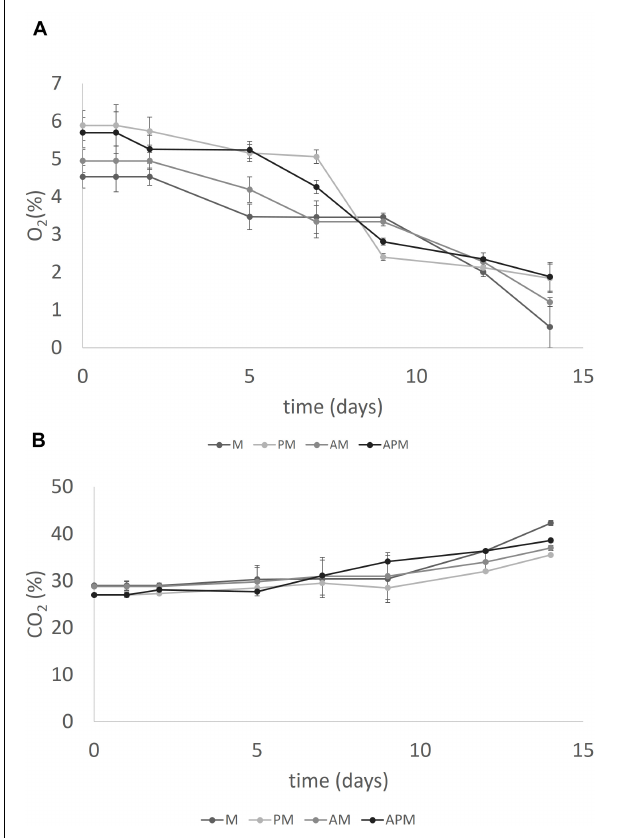
FIGURE 5 | Evolution of O 2 (A) and CO 2 (B) in the head-space of melon pieces inoculated with L. plantarum c19 and packed in modified atmosphere. Mean ± standard deviation. For the acronyms of samples see Materials and